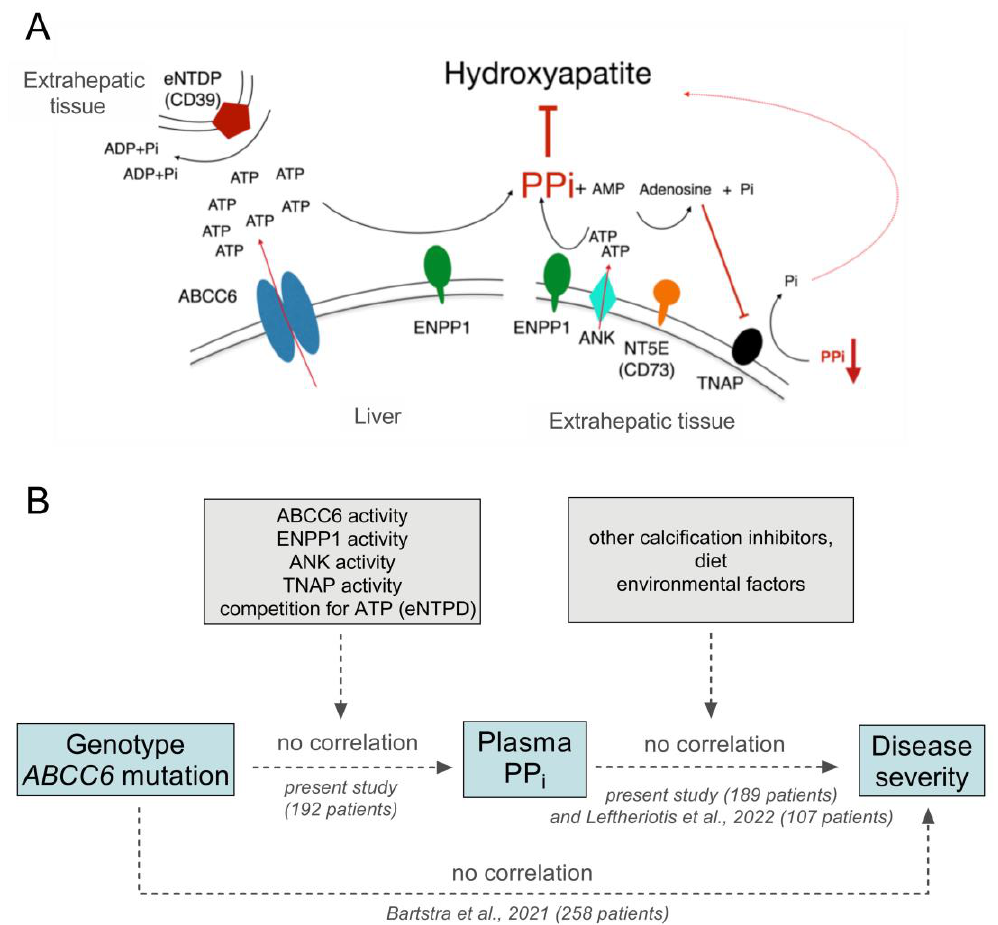
Figure 4. Crucial players of plasma pyrophosphate homeostasis, and factors modifying plasma pyrophosphate level and disease severity in pseudoxanthoma elasticum. ( A ) The activity of ABCC6 protein and ENPP1 in the liver are responsible for approximately 60% of extracellular PP i in the circulation. In extrahepatic tissues, human progressive ankylosis (ANKH) protein, similarly to ABCC6 protein, facilitates ATP release from cells, while tissue-nonspecific alkaline phosphatase (TNAP) cleaves PP i , thus lowering its concentration. AMP is hydrolyzed by NT5E (CD73) to inorganic phosphate and adenosine, and the latter down-regulates TNAP expression, thus controlling its activity and increasing plasma PP i . Ectonucleoside triphosphate diphosphohydrolase enzymes (eNTPDs) compete for ATP with ENPP1. ( B ) Left: the expression and activity of ABCC6 protein, ANK and ENPP1 all contribute to increasing plasma PP i , while TNAP, on the other hand, decreases it. Competition for extracellular ATP in plasma by ENPP1 and eNTPDs may also influence pyrophosphate homeostasis. ( B ) Right: other calcification inhibitors, which exert their effect independent of plasma PP i concentration, as well as dietary and environmental factors, can also impact calcification symptoms of PXE.